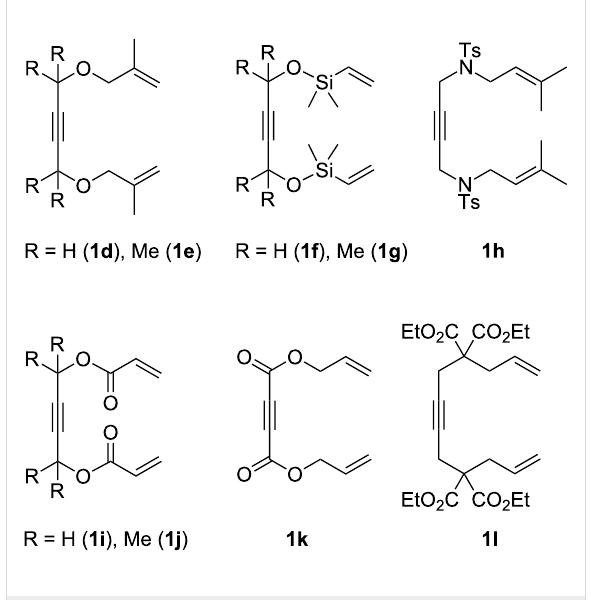
Figure 1: The substituted 1,11-dien-6-ynes that did not undergo cyclo- isomerization in the presence of the cobalt catalytic